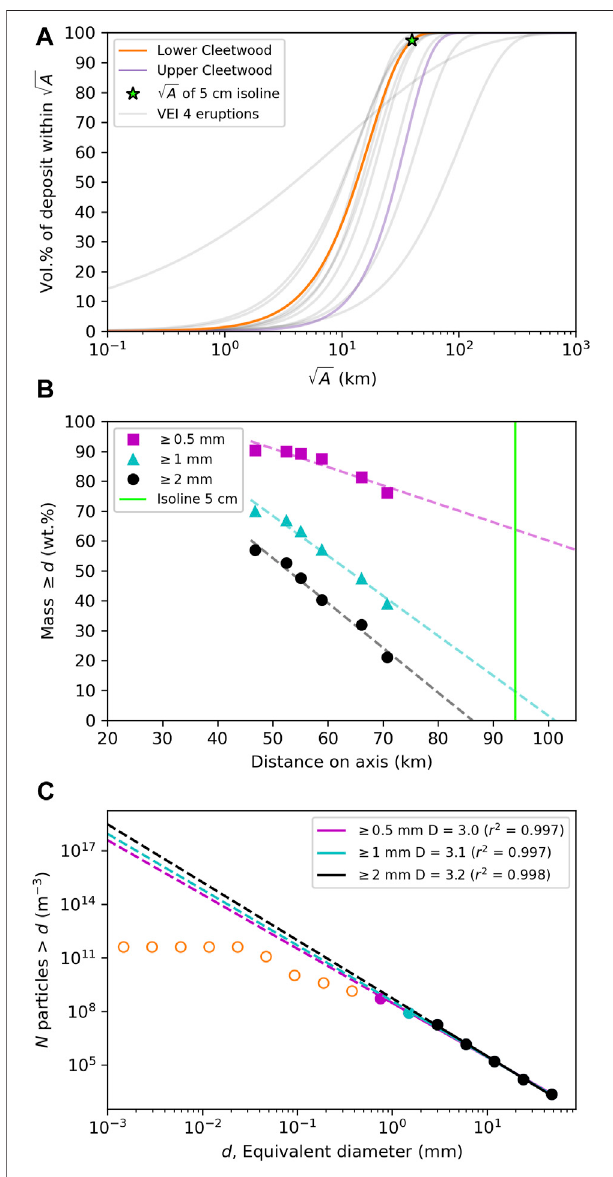
FIGURE 11 | (A) Cumulative volume of tephra of lower Cleetwood of the Cleetwood eruptive sequence as a function of the square root of the (cid:1)(cid:1) √ isopach area, A (km). Data for all other VEI 4 eruptions compiled by Bonadonna and Costa (2012) are also plotted, in gray, for comparison. (B) Mass fraction (in wt.%) of particles ≥ 0.5 mm, ≥ 1 mm, or ≥ 2 mm as a function of the distance from the vent along the dispersal axis of lower Cleetwood. The vertical green line represents the furthest extent of the 5 cm isoline ( Figure 4B ). Because all locations plotted lie on the dispersal axis, the mass ≥ d for each grain-size likely represents maximum values. (C) Cumulative number density, N > d , vs equivalent diameter, d , for lower Cleetwood of the Cleetwood eruption (i.e., TGSD) and best fi ts obtained using a power-law distribution for all particles ≥ 0.5 mm, ≥ 1 mm, and ≥ 2 mm. The fractal dimension and Pearson coef fi cient obtained for each case are given in the